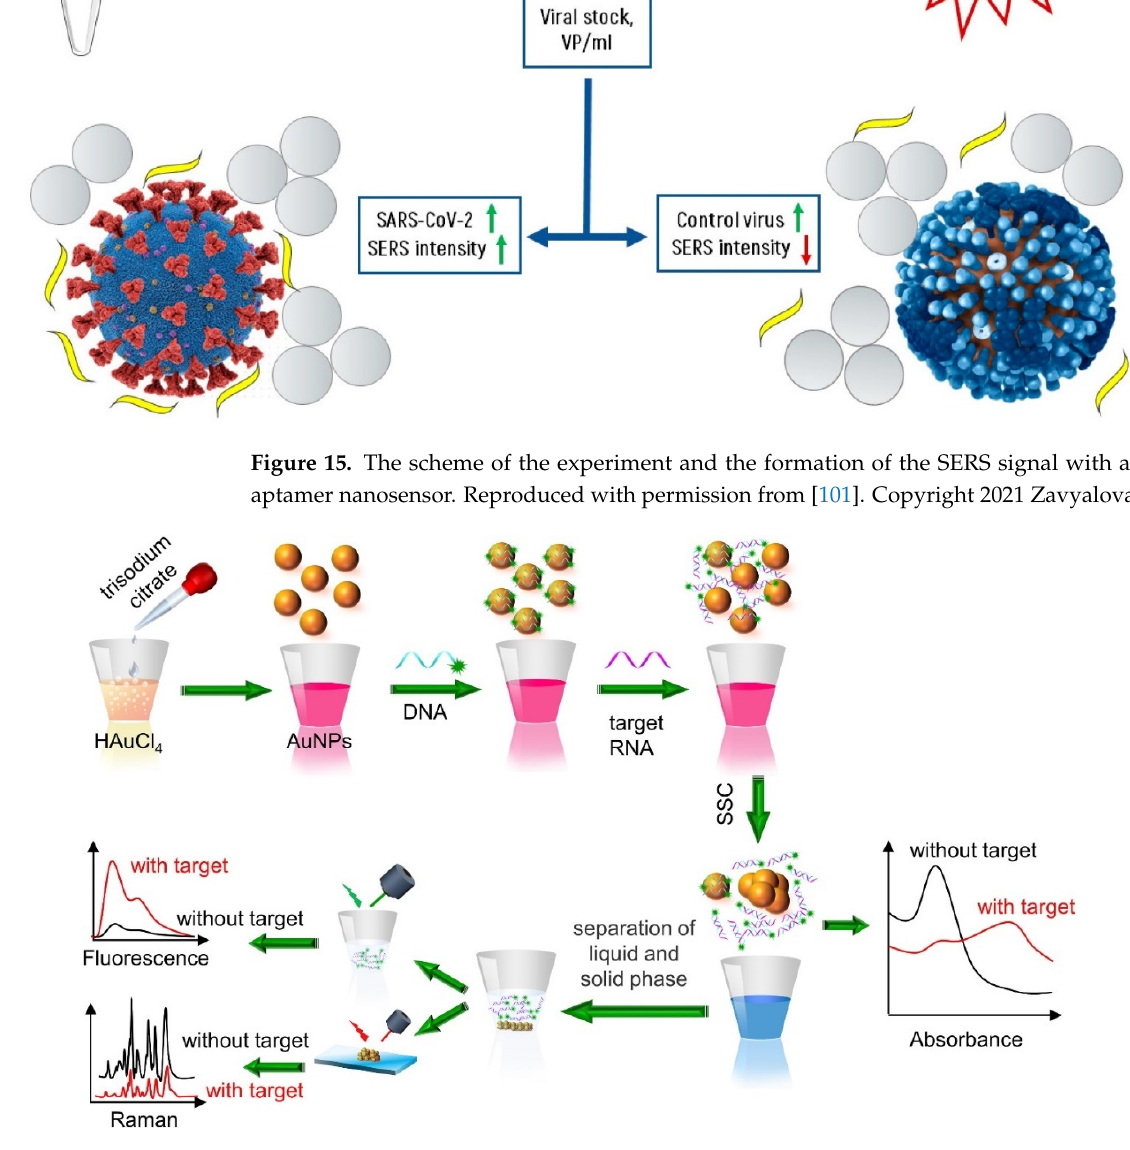
Figure 16. Scheme of the triple-mode nanosensor for detection of SARS-CoV-2. Reproduced with permission from [103]. Copyright 2021 Elsevier B.V. permission from [103]. Copyright 2021 Elsevier